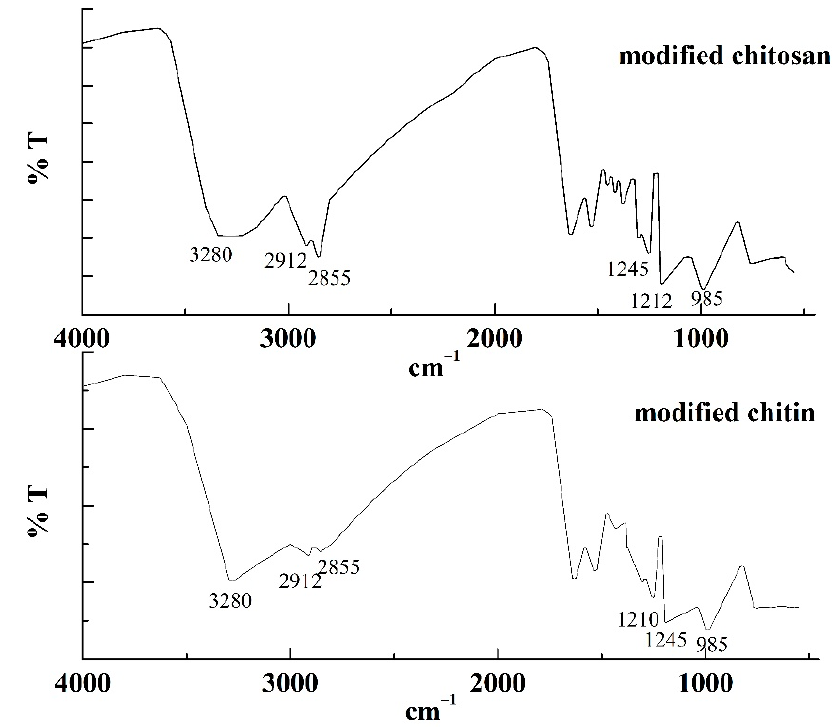
Figure 3. FTIR spectra for the modified chitosan and the modified chitin.